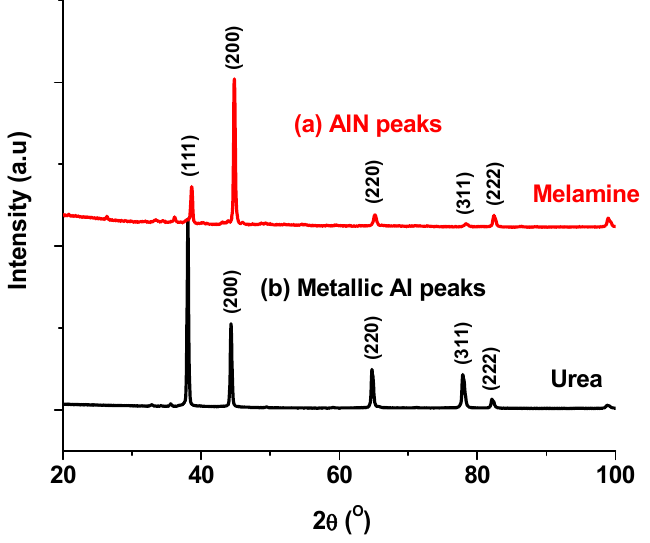
Figure 10. XRD patterns of in situ produced coatings in plasma by the reaction between Al powder and the two nitriding agents: ( a ) urea and ( b ) melamine.